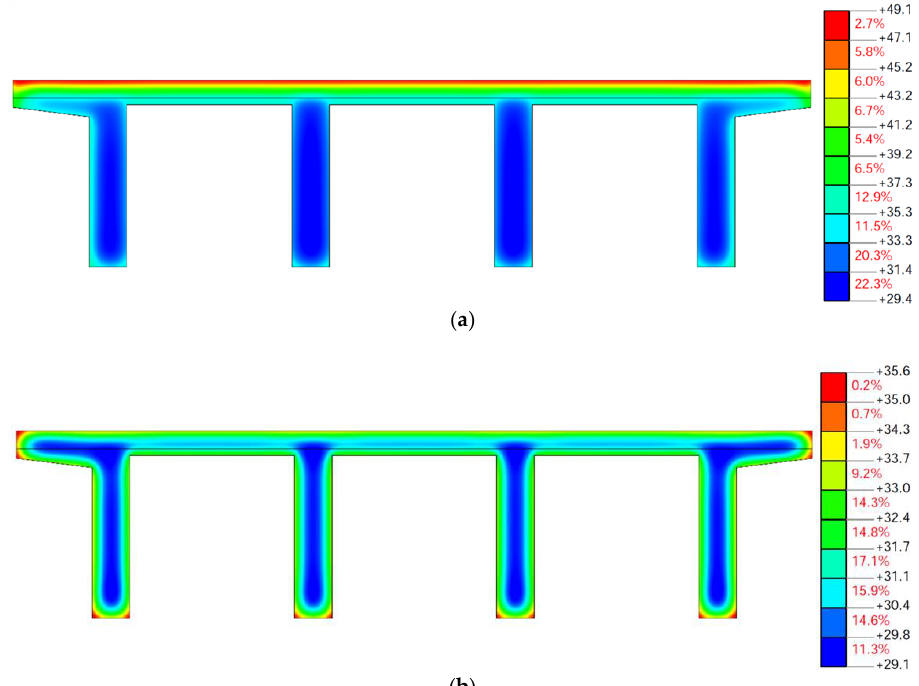
Figure 22. Temperature contour plots of T-shaped girder at 15:00 on 23 August 2012: ( a ) with solar radiation; and ( b ) without solar radiation.